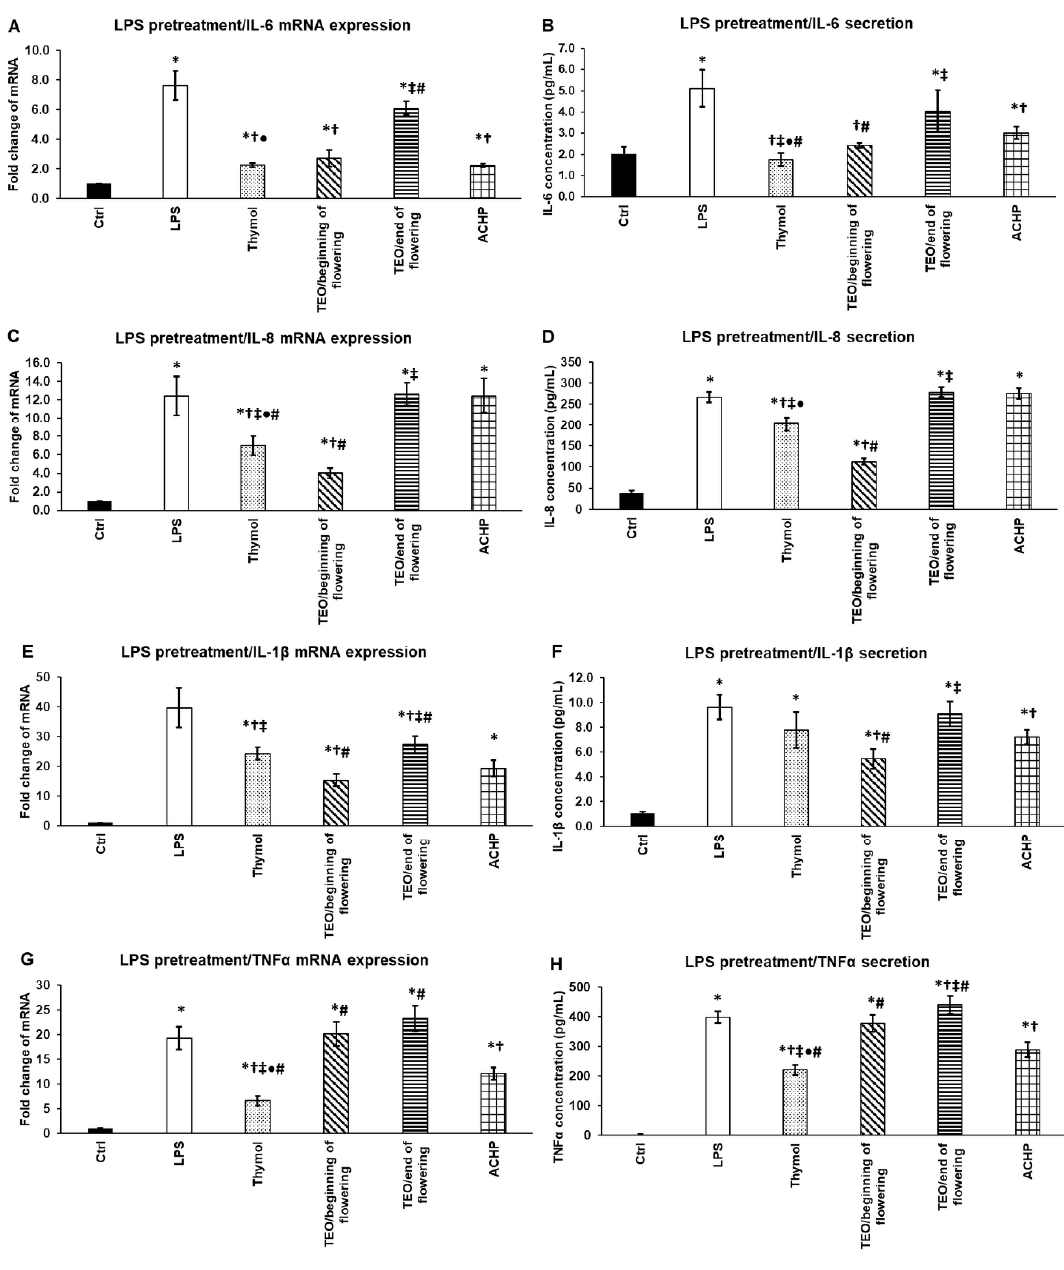
Figure 8. Effects of thymol, TEOs, and ACHP NF κ B inhibitor on mRNA ( A , C , E , G ) and protein ( B , D , F , H ) levels of proinflammatory cytokines IL-6, IL-8, IL-1 β , and TNF- α after LPS pretreatment. THP-1 cells were pretreated with 100 ng/mL LPS for 24 h and then with 500-fold diluted thymol, TEOs, or 5 μ M ACHP for 24 h. DMSO-treated cells were used as control of the treated cells. Real- time PCR for the proinflammatory cytokines was performed with SYBR green protocol. β -actin was used as housekeeping gene, and the relative expression of controls was regarded as 1. Pro-inflam- matory cytokine secretions were determined using IL-6-, IL-8-, IL-1 β -, and TNF- α -specific ELISA kits according to the manufacturer’s protocols. The columns represent mean values, and error bars represent standard deviation (SD) for three independent experiments (n = 3). The assays were car- ried out in triplicate in each experiment. Asterisk indicates p < 0.05 compared to control. Cross marks p < 0.05 compared to LPS treatment. Double cross shows p < 0.05 compared to TEO/beginning of flowering. Bullet marks p < 0.05 compared to TEO/end of flowering. Number sign indicates p < 0.05 compared to ACHP treatment. Statistical analysis was carried out by two-way ANOVA followed by Scheffe’s post hoc test.